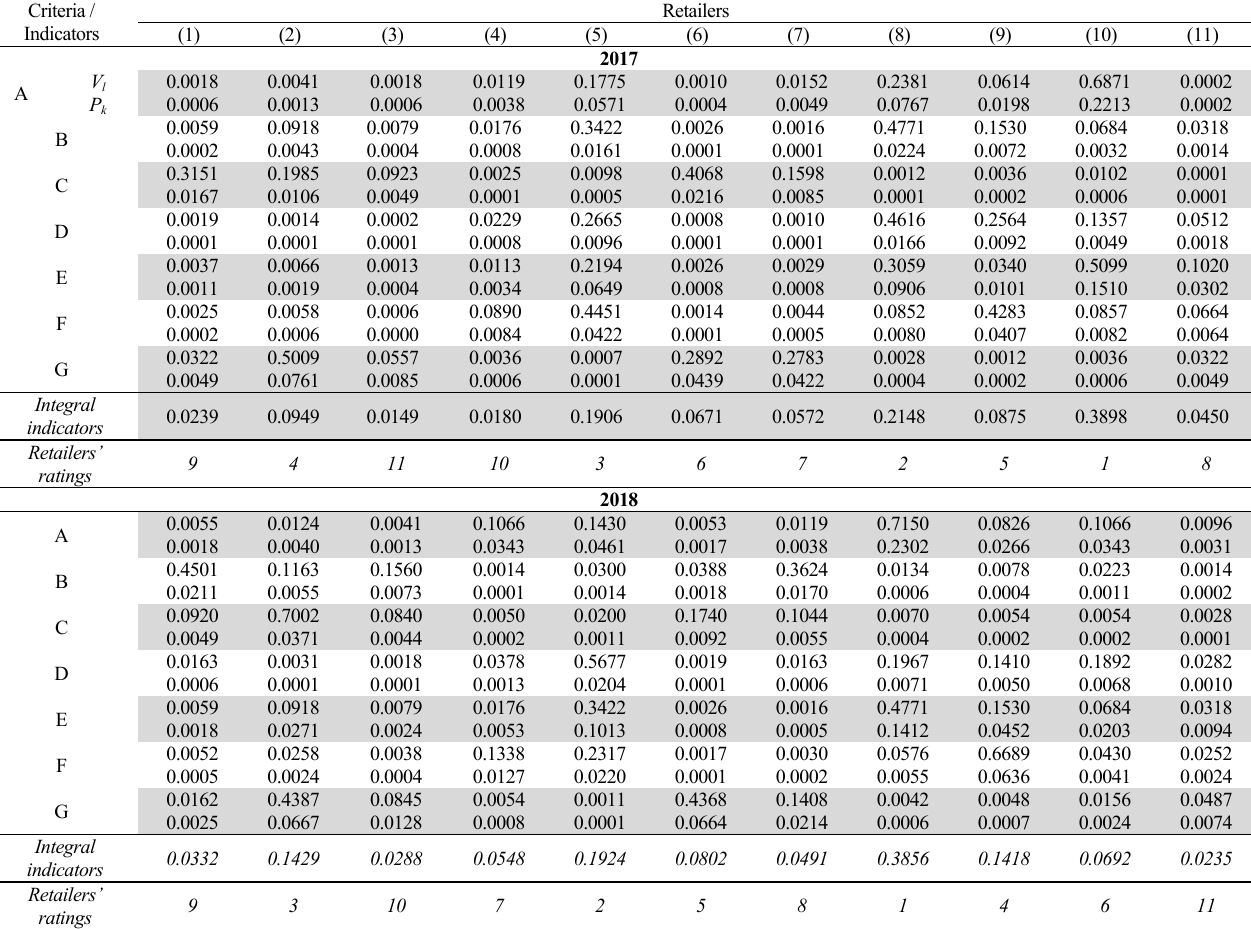
Ranking positions of the analyzed retailers by the integral competitiveness indicator in 2017-2019 Criteria /